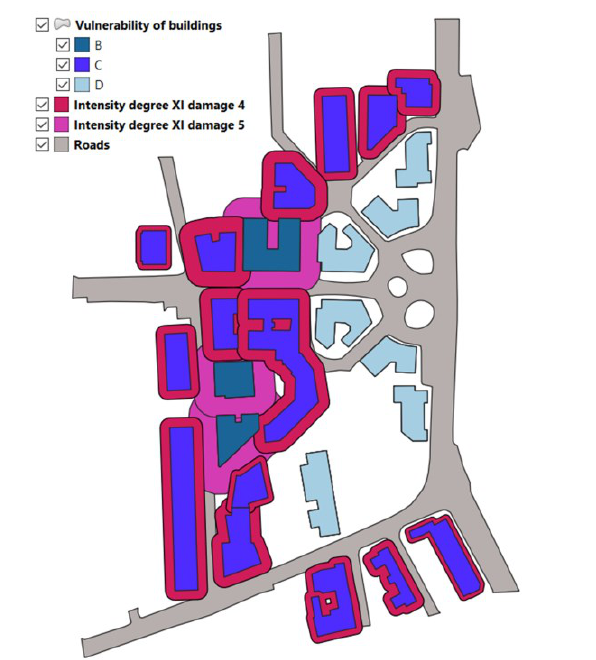
Figure 12. The scenario for intensity degree XII: in grey clear